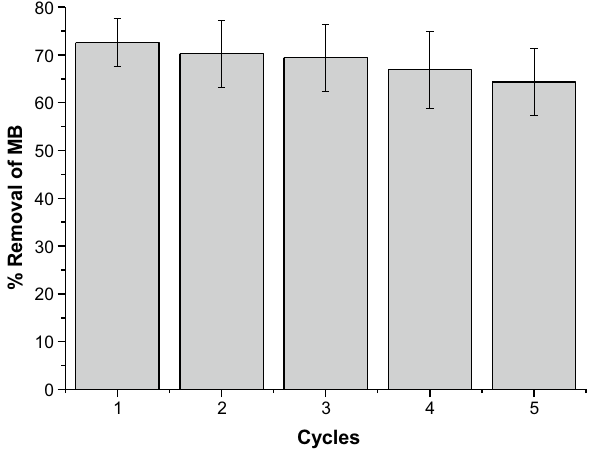
Fig. 10 % removal of MB in consecutive transport experiments pre- ferment on the same membrane; Feed phase: MB 100 mg/L, pH 11. Stripping phase: 0.3 M HCl. Membrane: RC8:0.05 g/g base poly- mer + 0.4 mL (2-NPOE)/g base polymers. Values obtained after 30 h of experimentation. %RSD in parentheses, stirring rate 600 rpm,